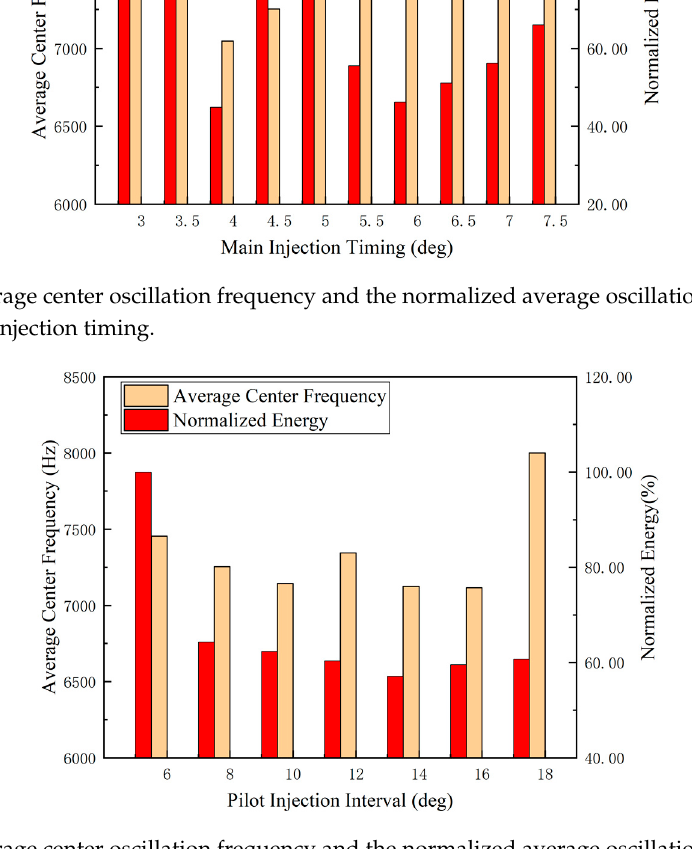
Figure 24. Average center oscillation frequency and the normalized average oscillation energy under di ff erent pilot injection interval.